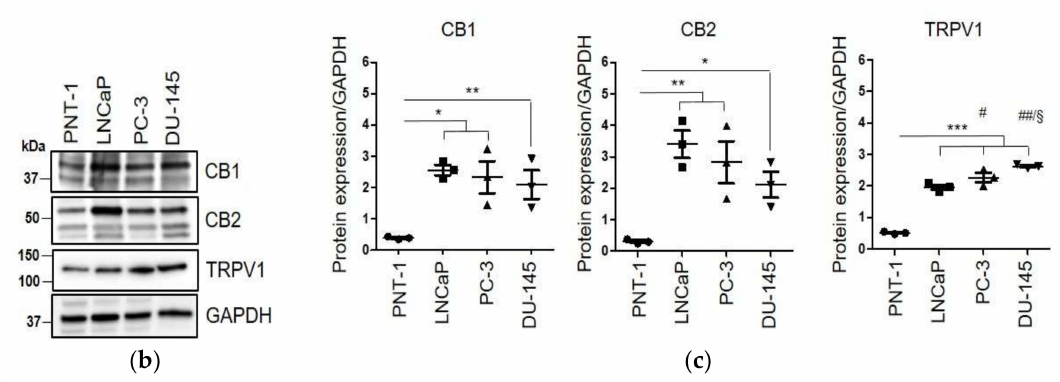
Figure 1. WIN 55-212.2 mesylate impacts on prostate cancer cell survival without a ff ecting healthy prostate epithelial cells ( a ) Normal prostate epithelial cells (PNT-1), androgen-sensitive (LNCaP), and insensitive (PC-3 and DU-145) prostate cancer cells were incubated with increasing concentrations of WIN 55-22.2 mesylate and CBD for 24 h. Cell survival measurements by means of data obtained by crystal violet staining are shown ( n = 3). p -Values were determined by Student’s t test. * p < 0.05, ** p < 0.01, *** p < 0.001 WIN versus control (Untr); # p < 0.05, ### p < 0.001 CBD versus Untr. ( b ) Representative immunoblot of CB 1 , CB 2 and TRPV1 expressions in PNT-1 and prostate cancer cell lines ( c ) Quantitative results of western blot analysis. Relative expressions were normalized respect to GAPDH. Each dot represents a biological replicate. Data express means ± SEMs. p -values were calculated by one-way ANOVA followed by Bonferroni’s multiple comparison test. * p < 0.05, ** p < 0.01, *** p < 0.001 versus PNT-1; # p < 0.05, ## p < 0.01 versus LNCaP; § p < 0.05 versus